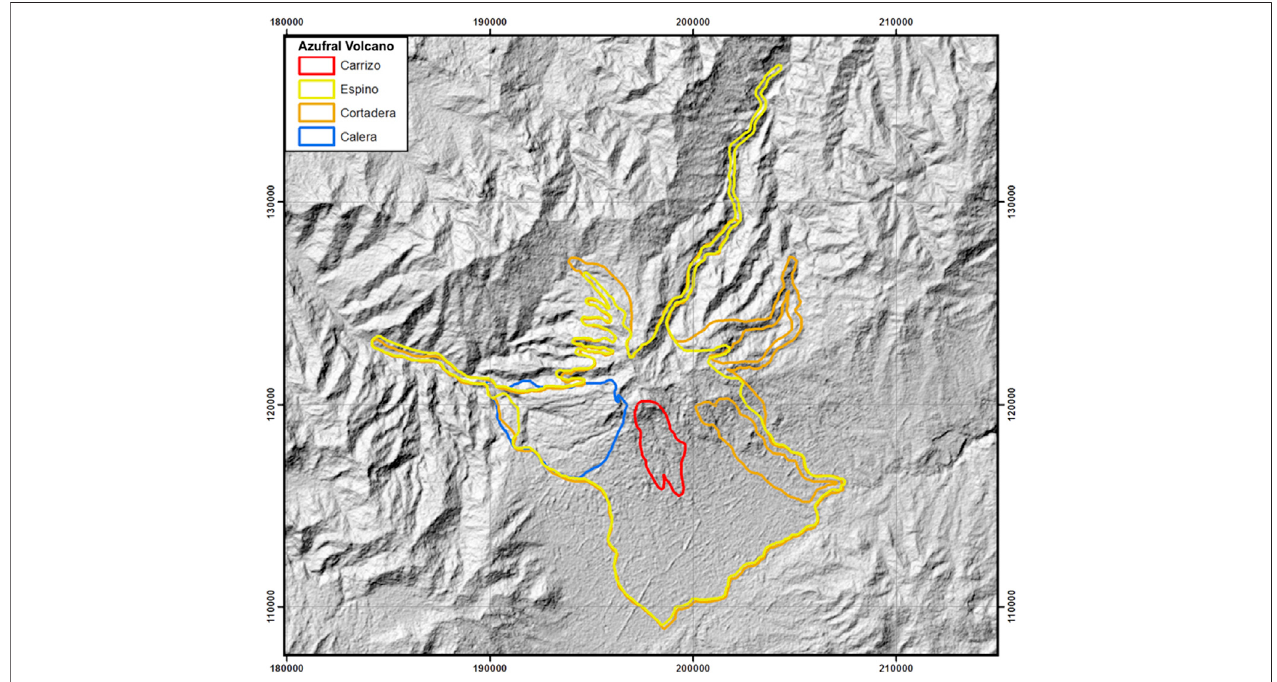
FIGURE 6 | Map showing mapped pyroclastic fl ow deposits for Azufral Volcano (Williams, 2015). Outline is known extent of each named deposit.